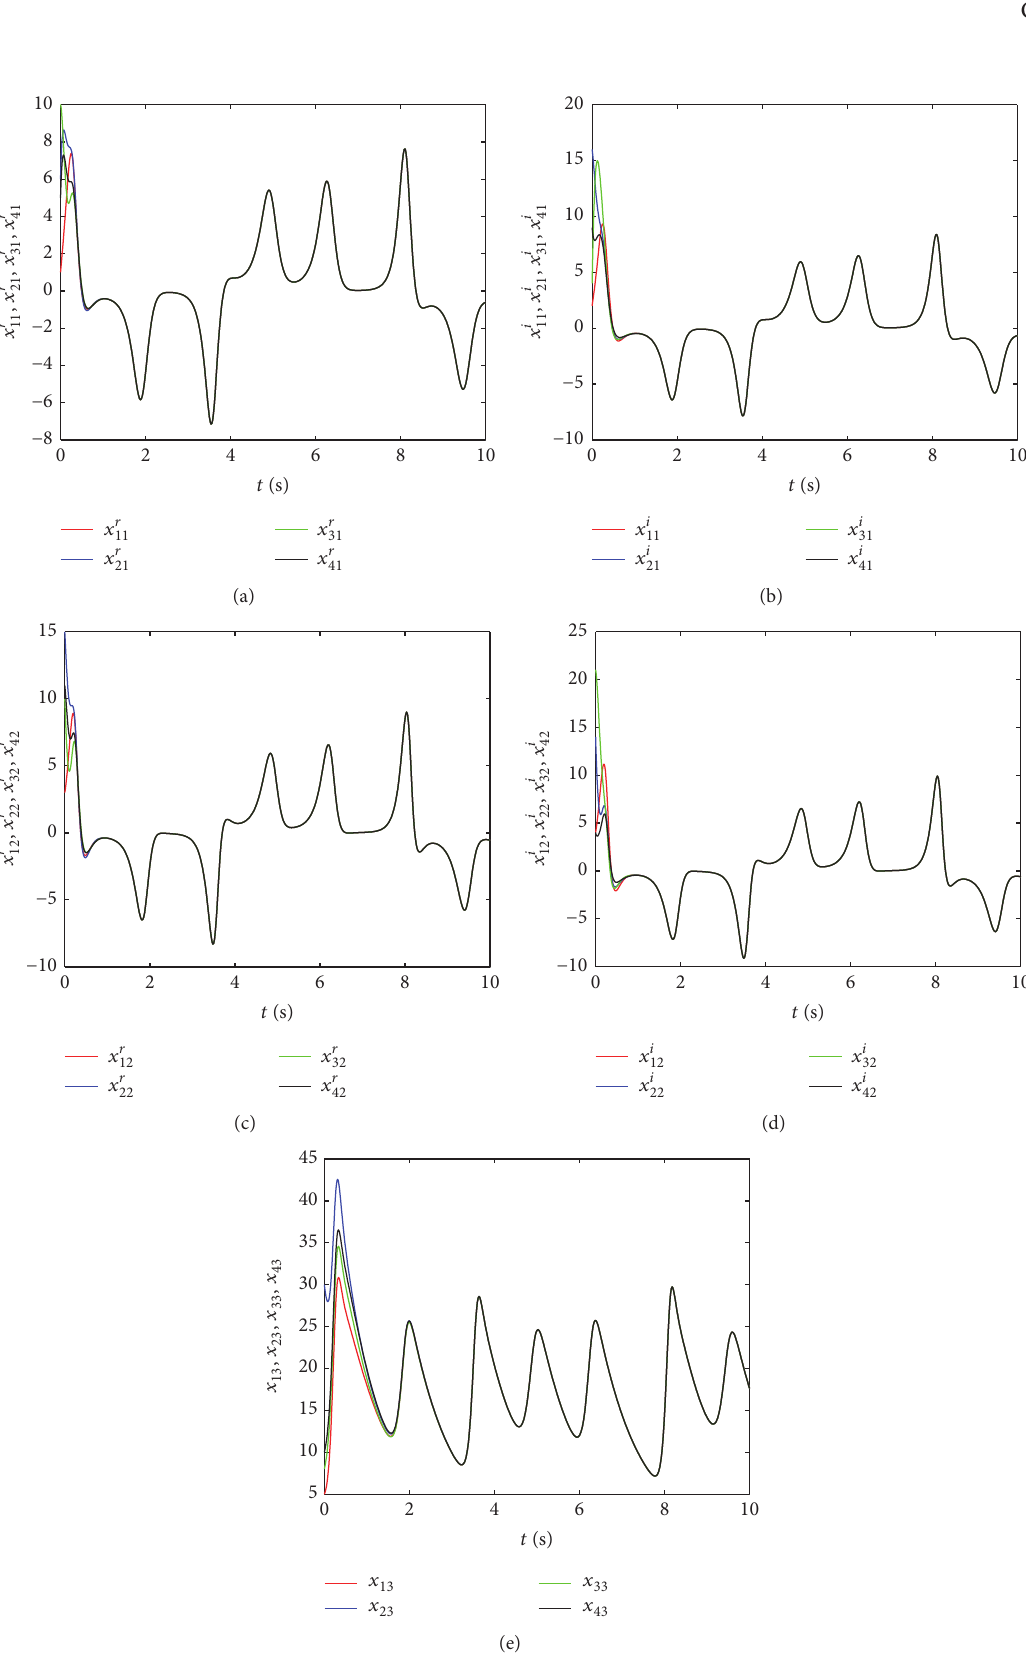
Figure 3: The state trajectories 𝑥 𝑘1 , 𝑥 𝑘2 , and 𝑥 𝑘3 ( 𝑘 = 1, 2,3, 4 ) for synchronization of 4 -coupled complex PMSM